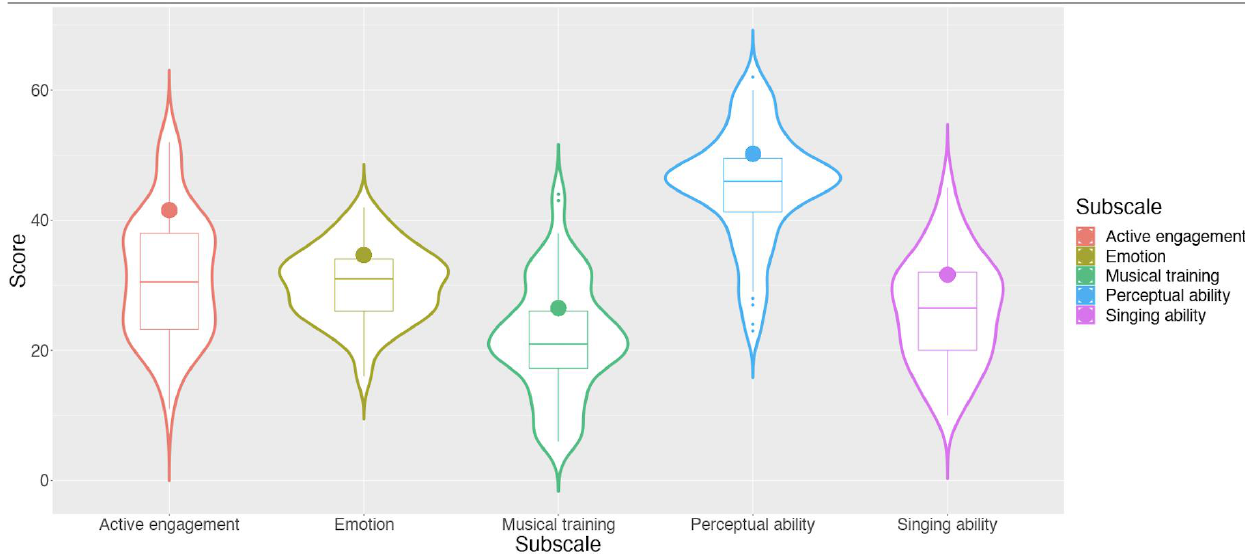
Figure 1. Musical score distribution of current sample compared against normed scores. Solid dots in each violin plot are the median scores from the normed data from Müllensiefen et al., 2014.